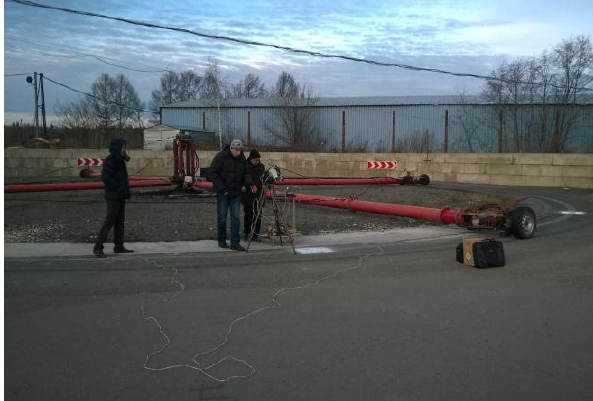
Figure 2. The “carousel” for simulating the motion of cars along the test ground